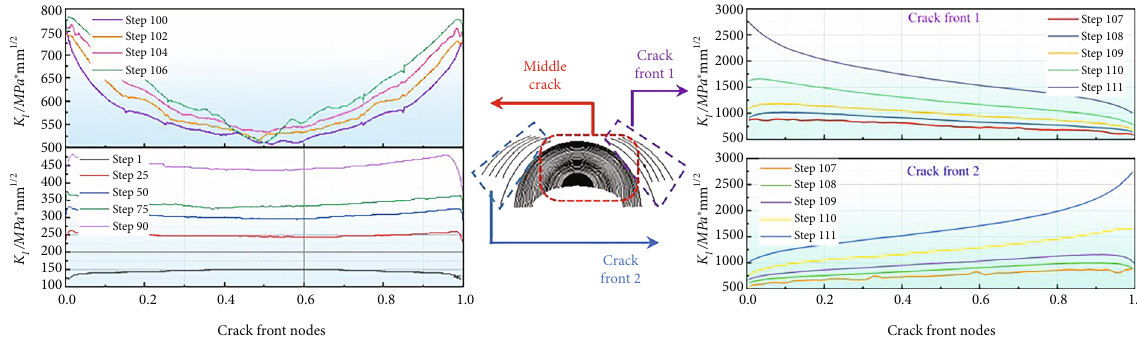
Figure 15: The change of K I along crack fronts during fatigue